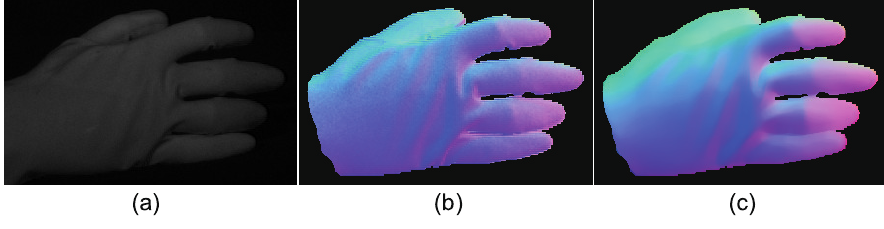
Figure 27. The results for hand with glove. Estimated geometry [pose 1]: ( a ) Estimated geometry [naive color photometric stereo] and ( b ) estimated geometry [our method]. Both color photometric stereos can estimate the surface normal of the dynamically deforming object.